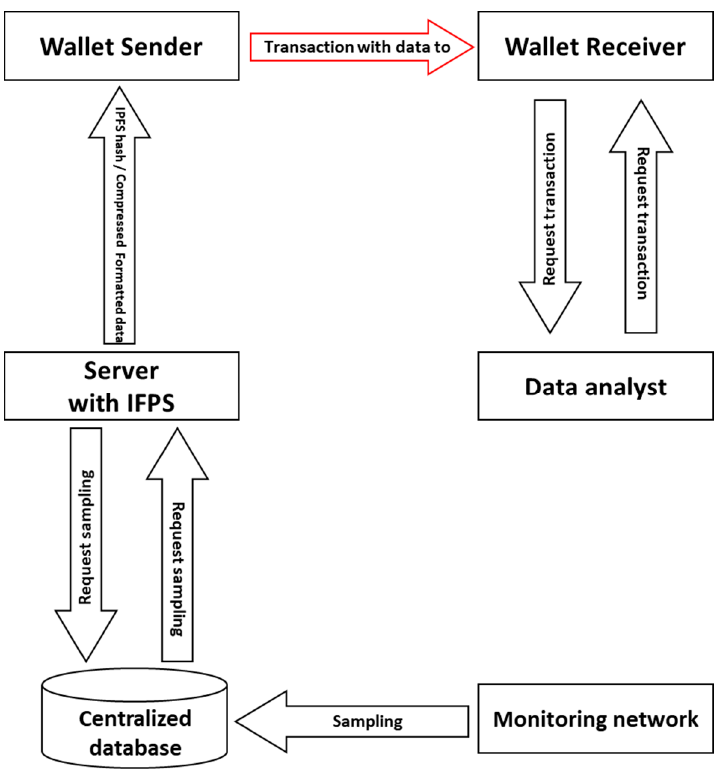
Figure 4. Conceptual path of the project.